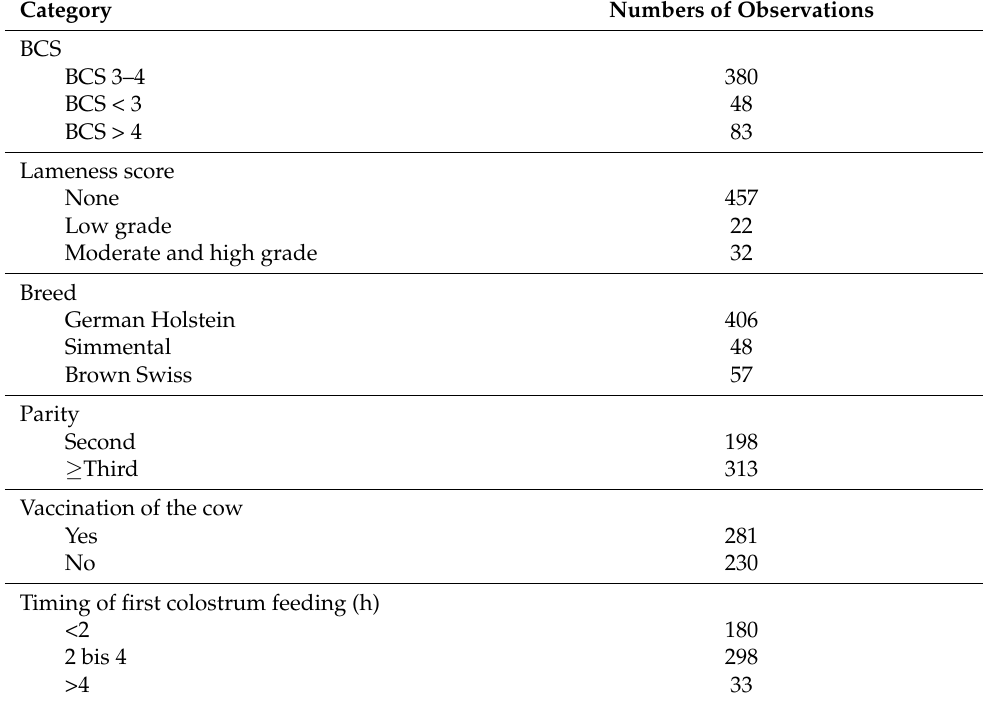
Table 1. Categorial variables with the respective categories and associated numbers of observations of 511 dairy cow–calf pairs included in the data